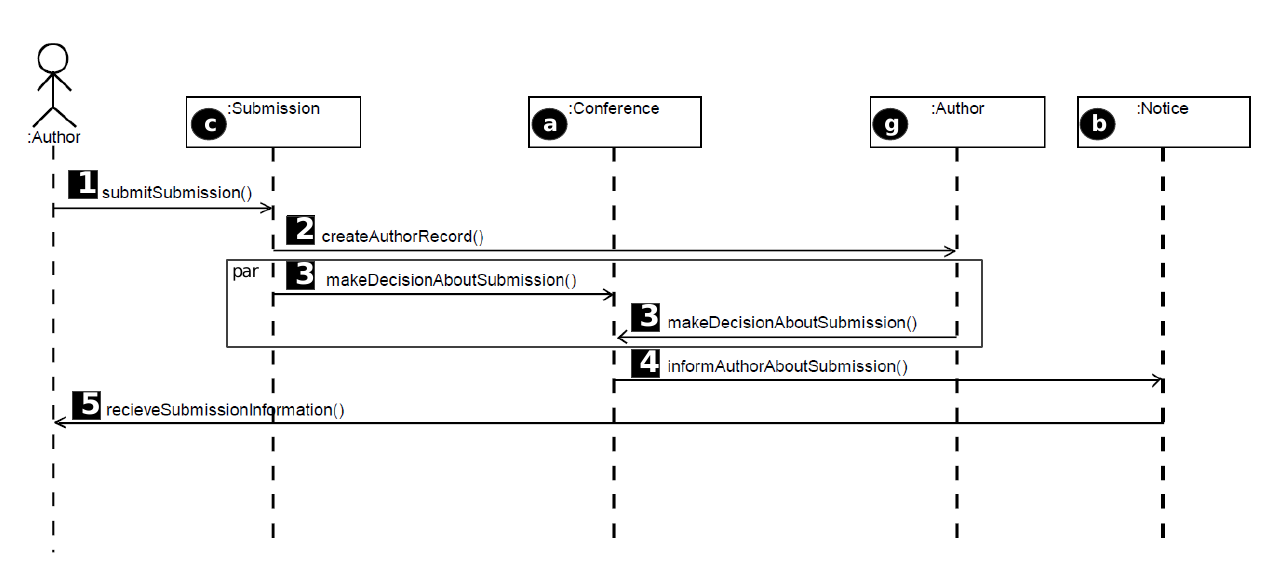
Fig. 3. The UML sequence diagram generated from the two-hemisphere